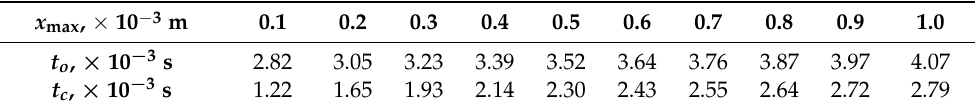
Figure 8. Calculated plunger displacement courses at different limit values x max = (0.1 . . . 1.0) × 10 − 3 m. Differences in functional parameters amounting to more than 1 ms on the opening and closing side of the injector were noted (Table 3). Table 3. The calculated values of opening t o and closing time t c at different maximum heights (stroke) plunger.